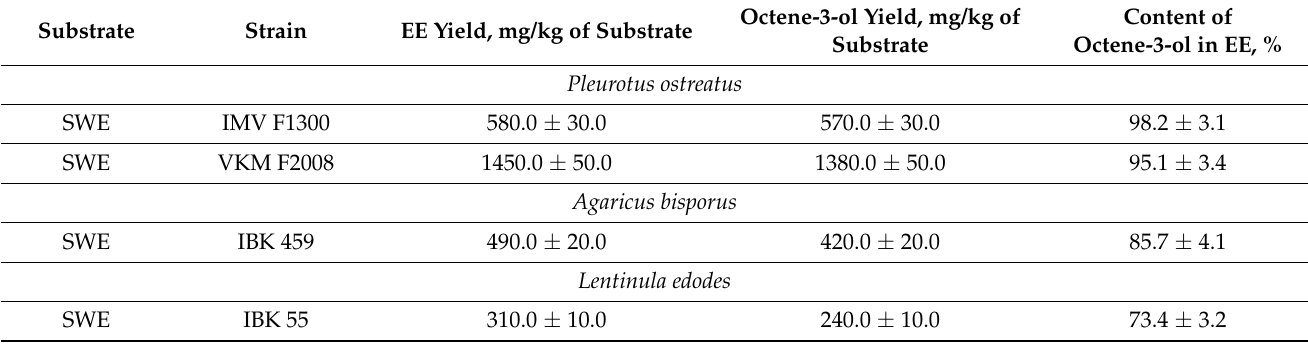
Table 4. The biosynthetic activity of basidiomycete strains in solid-phase cultivation. Octene-3-ol Yield, mg/kg of Content of Substrate Strain EE Yield, mg/kg of Substrate Substrate Octene-3-ol in EE, % Pleurotus ostreatus SWE IMV